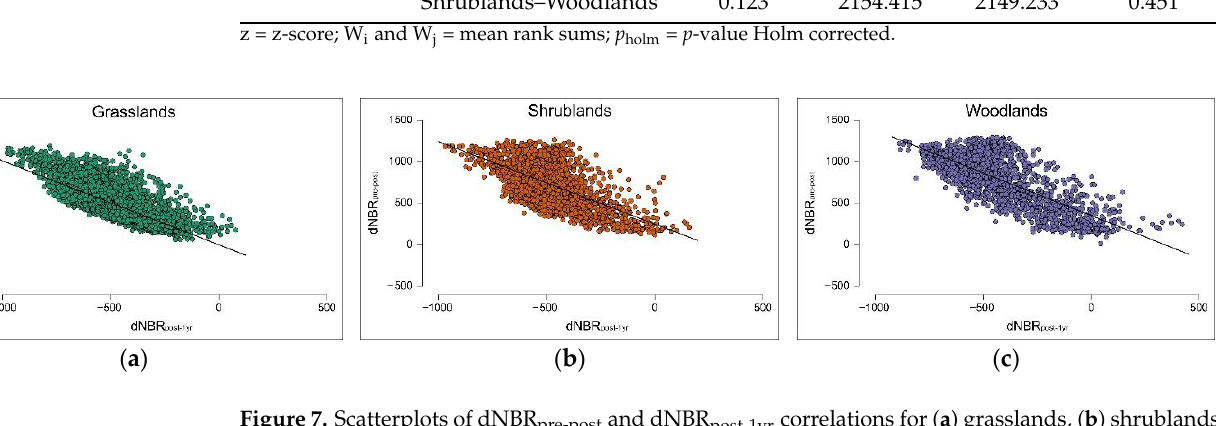
Table 5. Median values of percent coverage, the height of resprouts, and the total height of vegeta- tion. Values in brackets indicate median absolute deviations. N = number of plots.